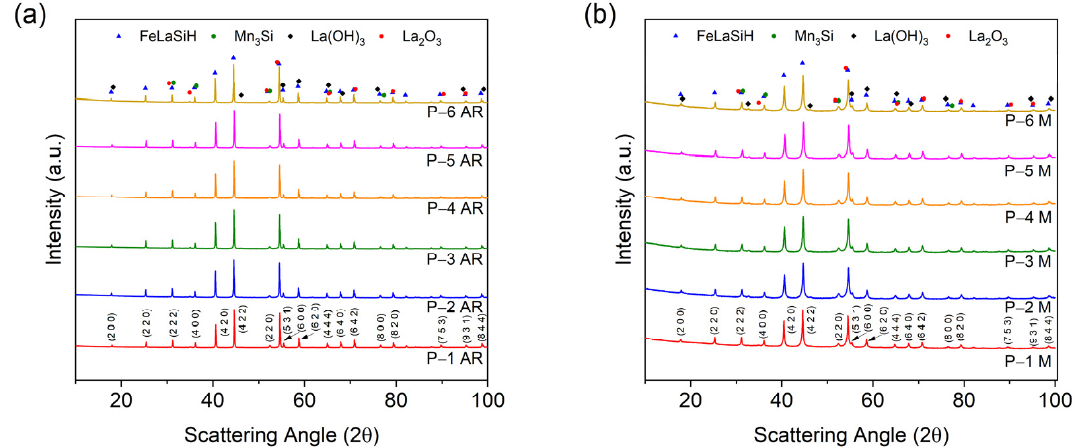
Figure 3. XRD patterns for ( a ) the as-received (ground) (P-1 AR–P-6 AR) and ( b ) the milled (30 min.) (P-1 M–P-6 M) magnetocaloric powders for scattering angles of 10–100° 2 θ . The Miller indices are shown for the peaks for powders P-1 AR and P-1 M.